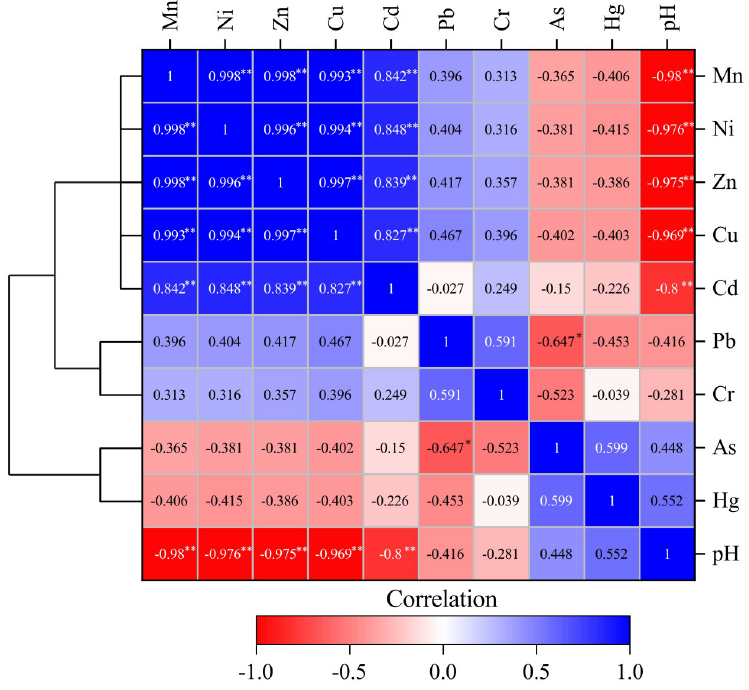
Fig 7. Heatmap of Pearson’s correlation coefficients combined with cluster analysis of heavy metals and pH. �� Correlation is significant at the 0.01 level. � Correlation is significant at the 0.05 level.